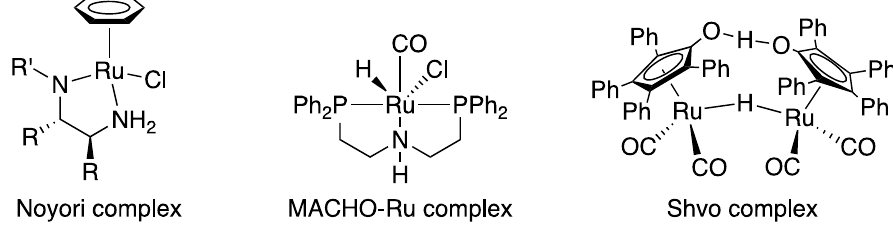
Figure 1. Representative examples of transition metal complexes with metal–ligand cooperative functions, which are not covered in this review.